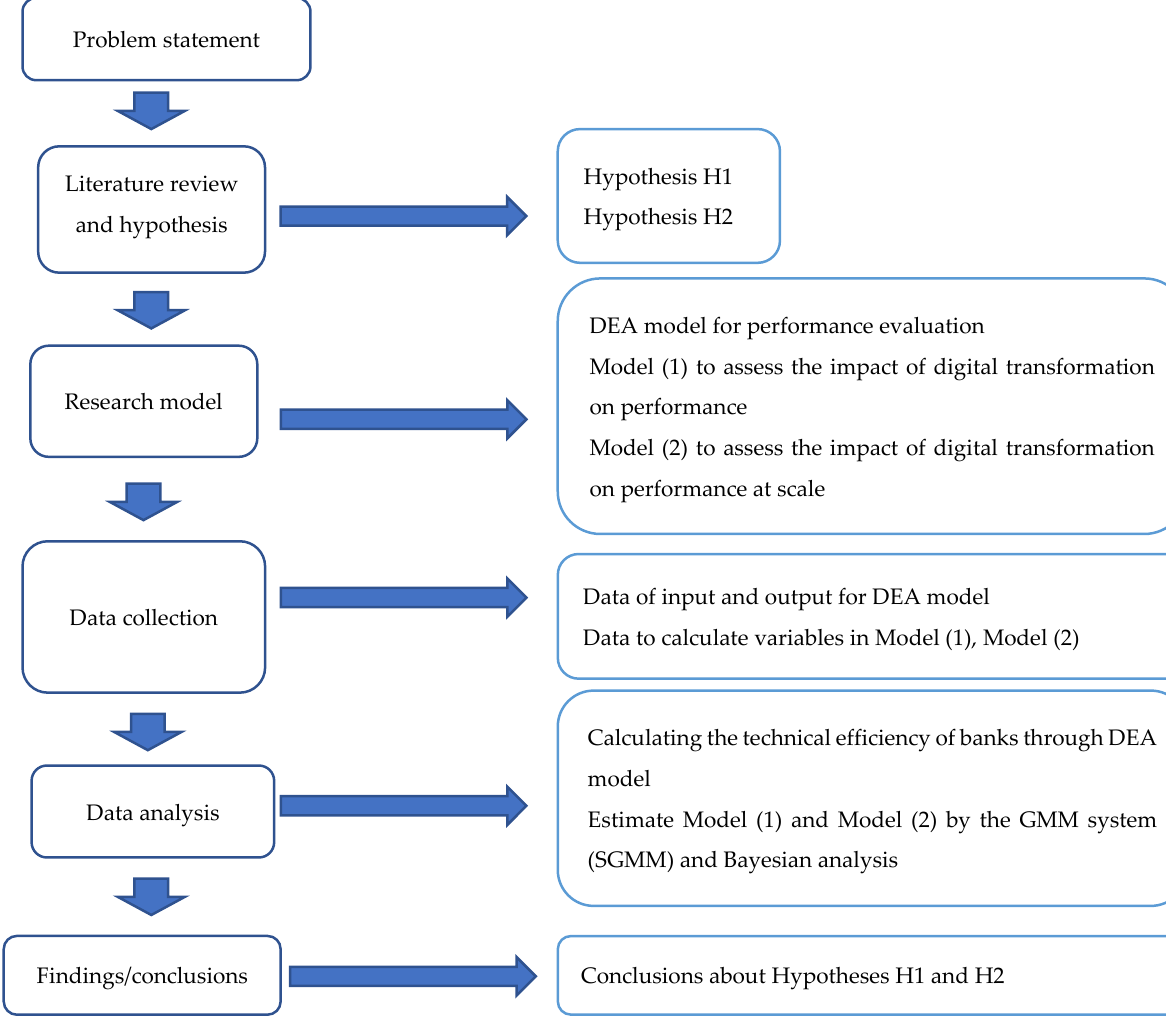
Figure 1. Research methodology scheme.